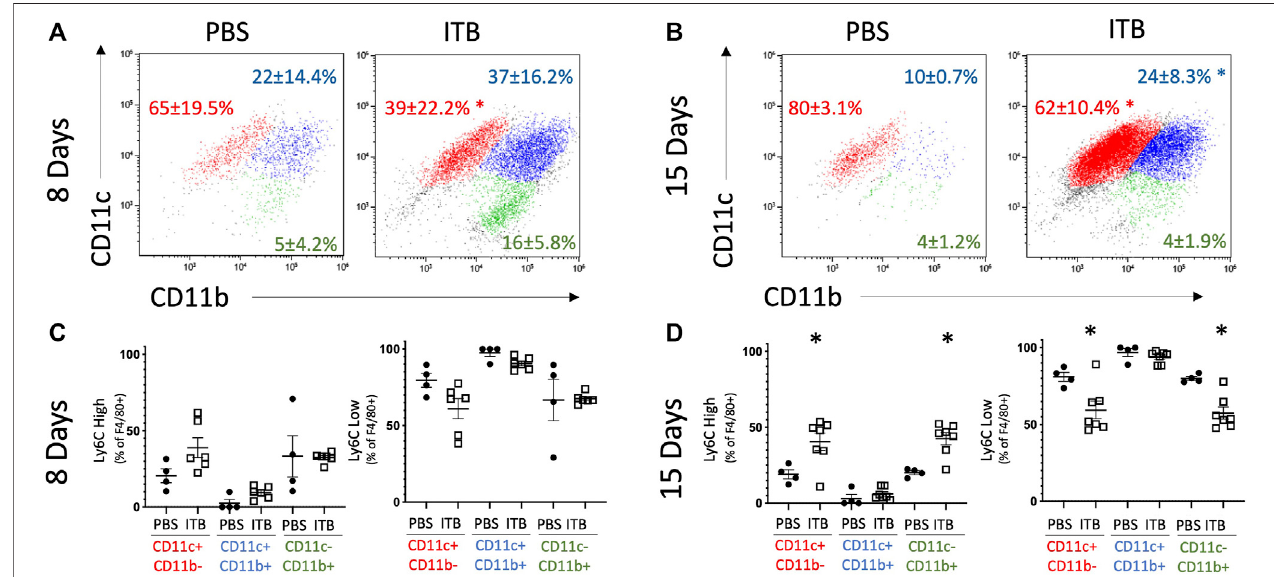
FIGURE 5 | MoMs are recruited to the lung and increase Ly6C expression following ITB. (A-B) CD11c and CD11b expression on MoMs demonstrate 3 distinct populationsat8 (A) and15 (B) dayspostinstillation. (C – D) Ly6CexpressionisgatedaseitherhighorlowinMoMscollectedat8 (C) and15 (D) dayspostinstillation.( n = 4 – 7 per group) * p < 0.05 compared to